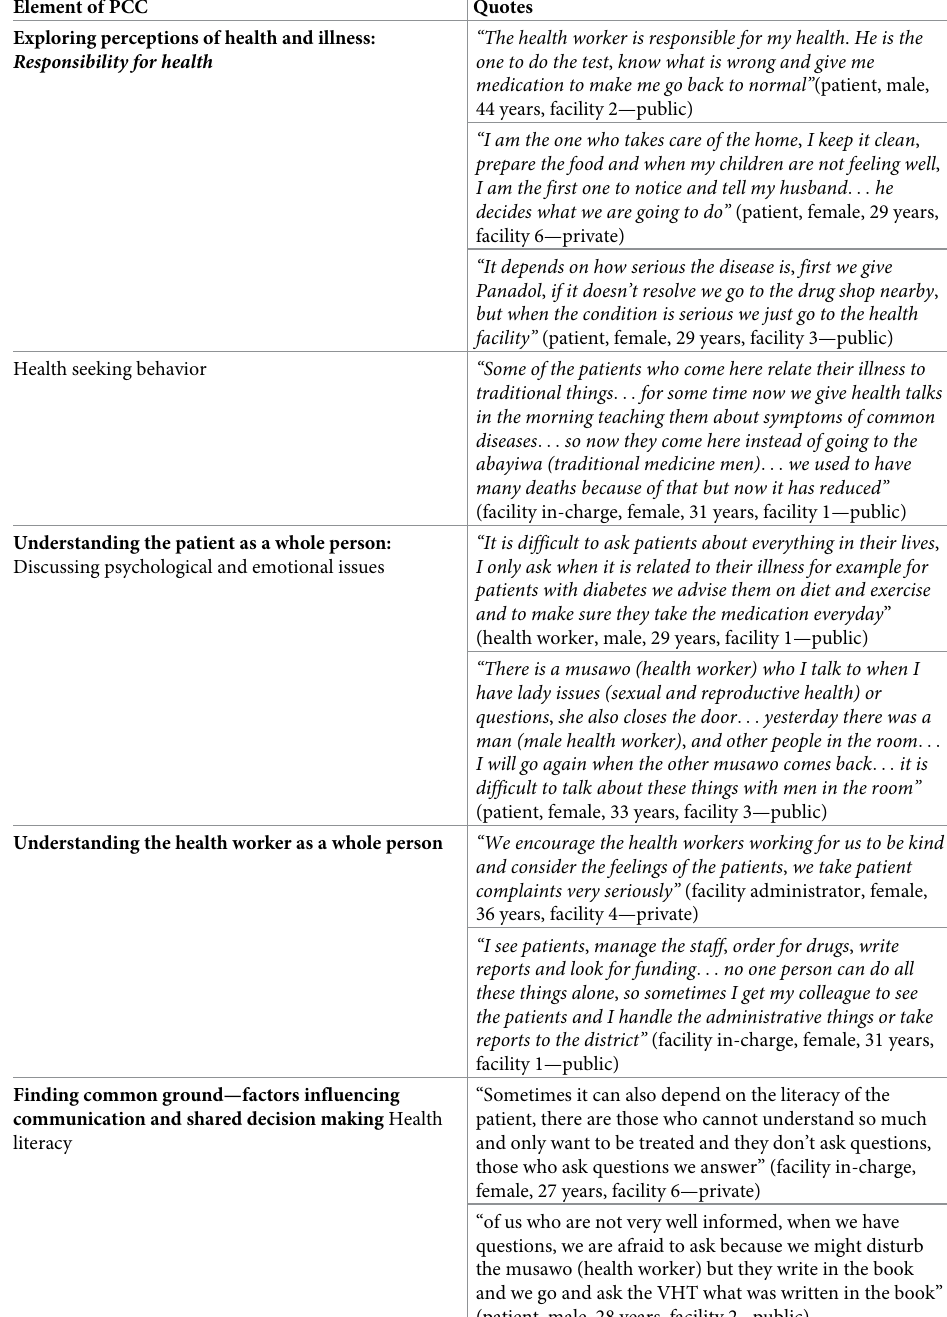
Table 5. Quotes exemplifying stakeholder perceptions on patient-centered